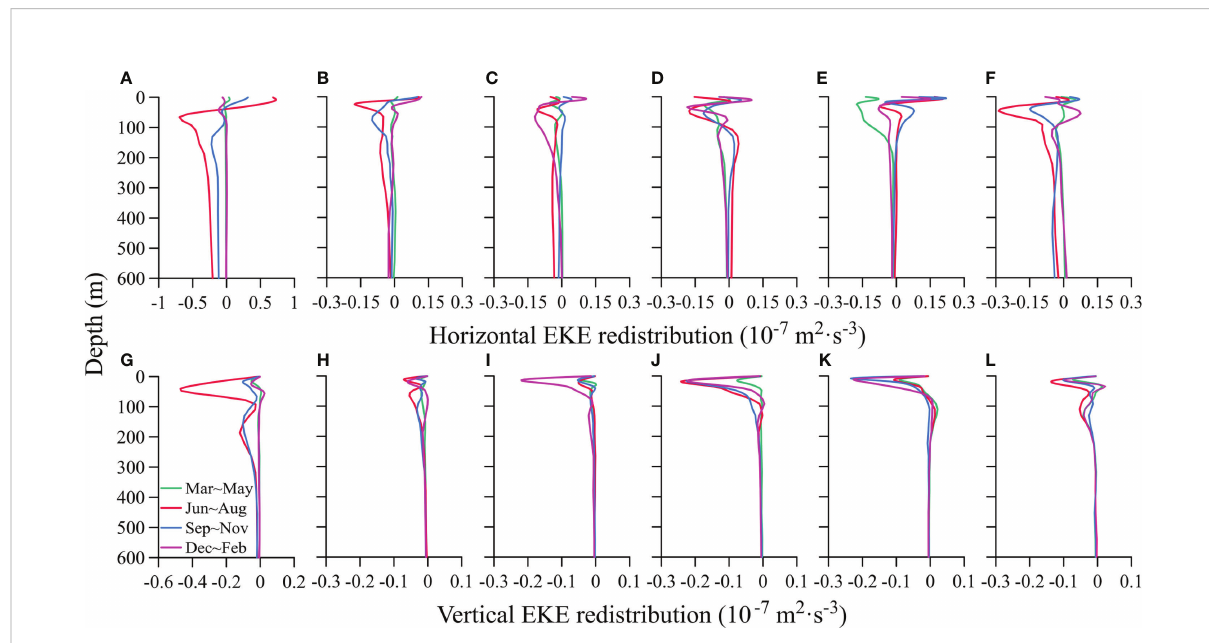
FIGURE 10 Seasonal pro fi les of horizontal eddy kinetic energy (EKE) redistribution (A-F) and vertical EKE redistribution (G-L) averaged in the A1, A2, A3, B1, B2, and B3